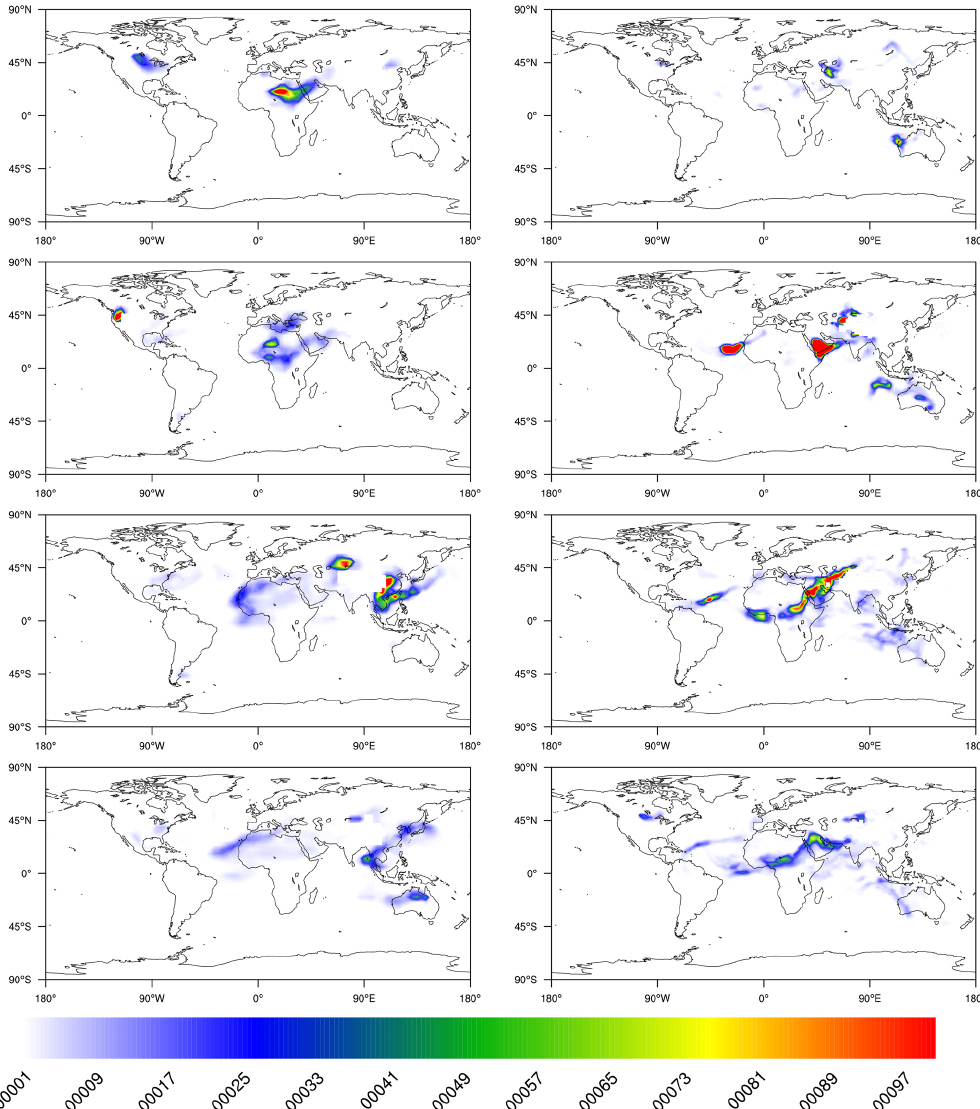
Figure 22. Dust mixing ratio of DU_AI (mgkg − 1 ) at 800hPa on 3, 6, 12, and 15 October using model resolutions of T 31 L 31 (left) and T 63 L 31 (right). The dust mixing ratio is masked due to high altitude in areas such as the Tibetan